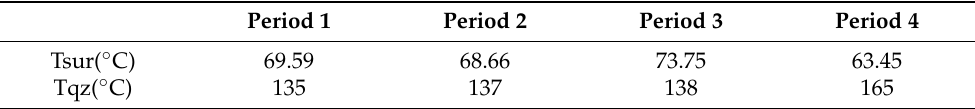
Table 5. Average surface and quartz geothermometer temperature of TYK in each